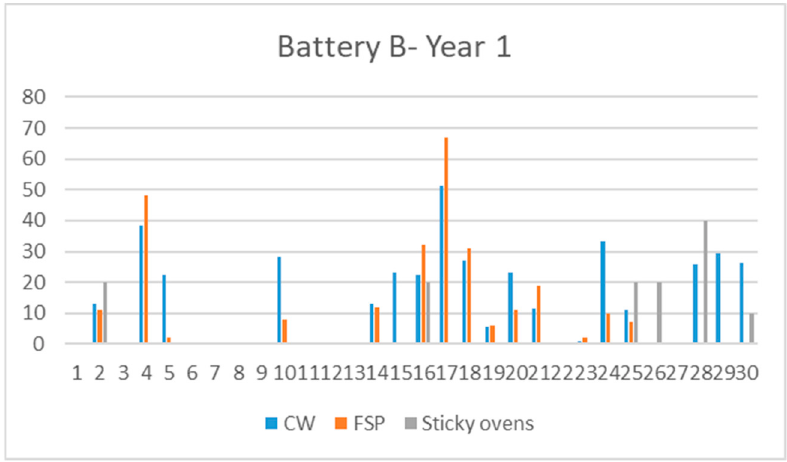
Figure 14. Sticky ovens and refractory repairs battery B, year 1.